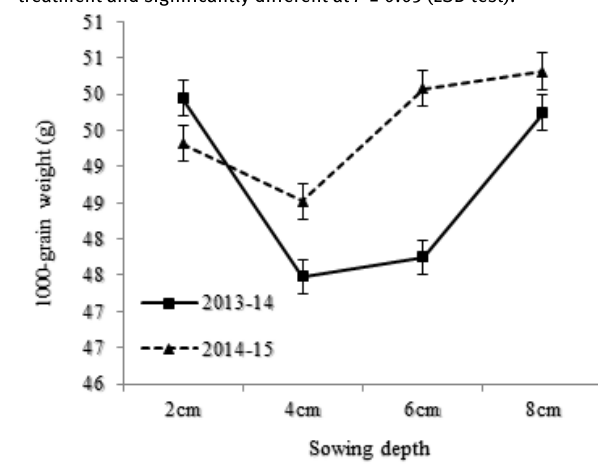
Figure 6: Plant dry weight as affected by sowing depth of wheat recorded at 10 DAS. Mean (±SD) was calculated from three replicates for each treatment and significantly different at P ≤ 0.05 (LSD test).